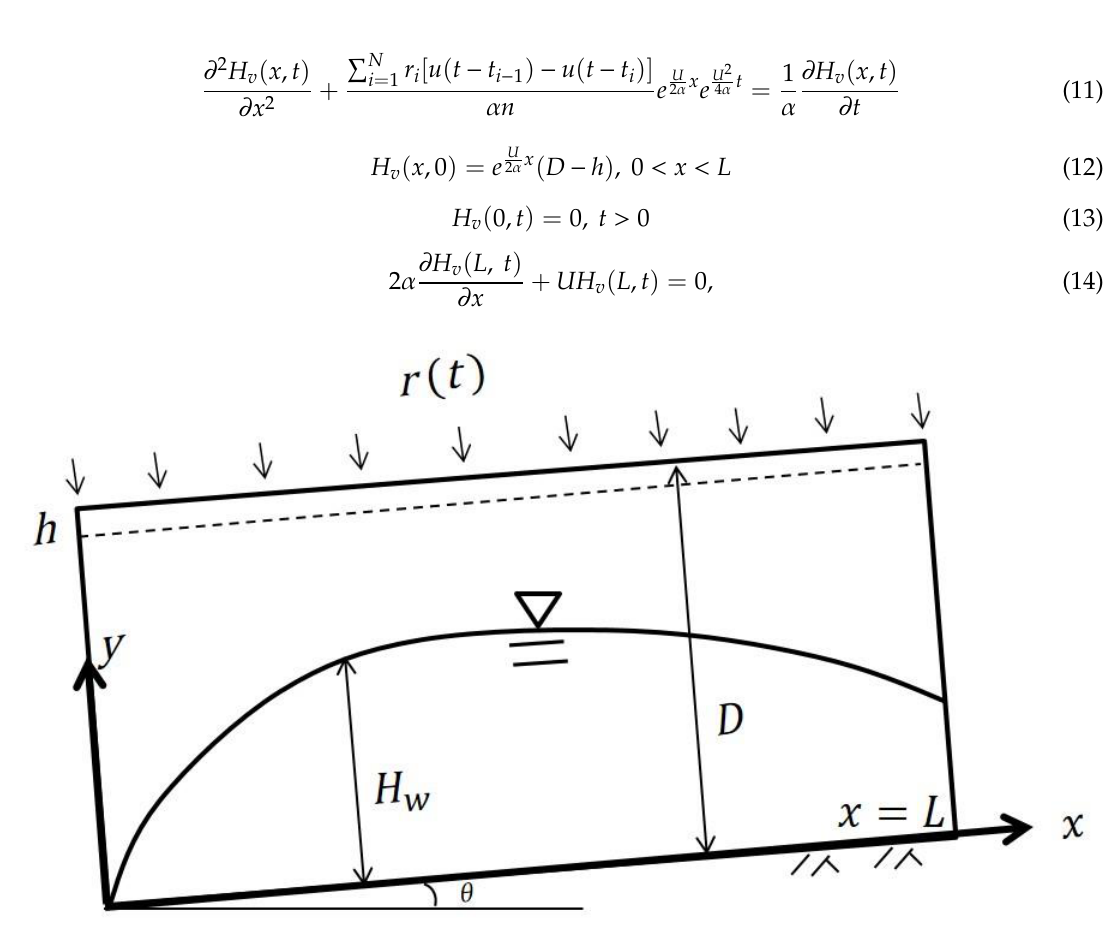
Figure 1. Schematic diagram of a sloping aquifer.